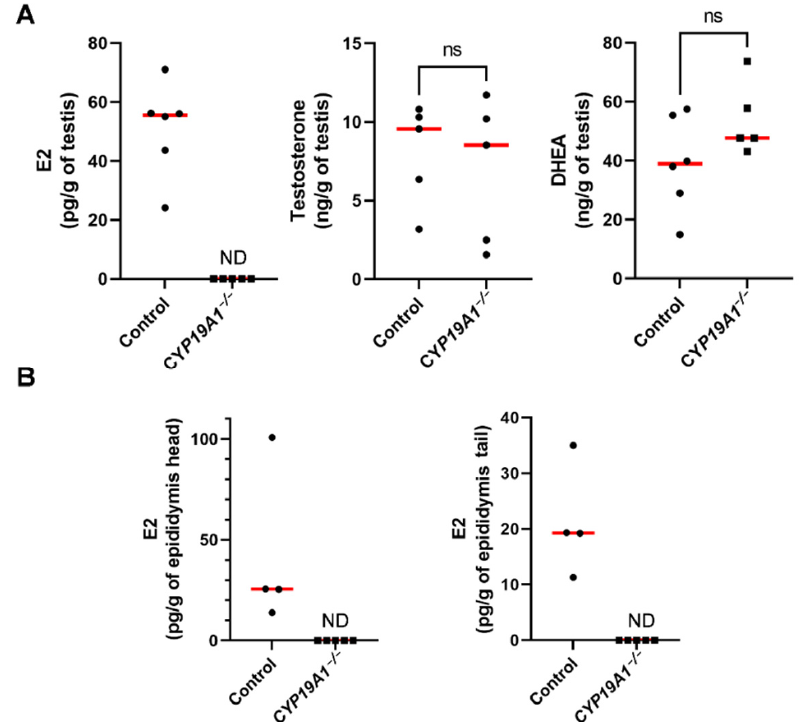
Figure 2. Steroid levels in the testis and epididymis in adults. ( A ) Dosage of 17 β‐ estra ‐ terone and DHEA concentrations in control and CYP19A1 − / − adult testes by GC/MS. ( B ) Dosage of diol (E2), testosterone and DHEA concentrations in control and CYP19A1 − / − adult testes 17 β -estradiol (E2) in the head and the tail of epididymis. Control n = 4 to 6; CYP19A1 − / − n = 5. The by GC/MS. ( B ) Dosage of 17 β‐ estradiol (E2) in the head and the tail of epididymis. Con ‐ median is shown in red. ND: not detected. Mann–Whitney test: p -value < 0.05. ns: trol n = 4 to 6; CYP19A1 − / − n = 5. The median is shown in red. ND: not detected. Mann– Whitney test: p ‐ value < 0.05. ns: non ‐ significant.